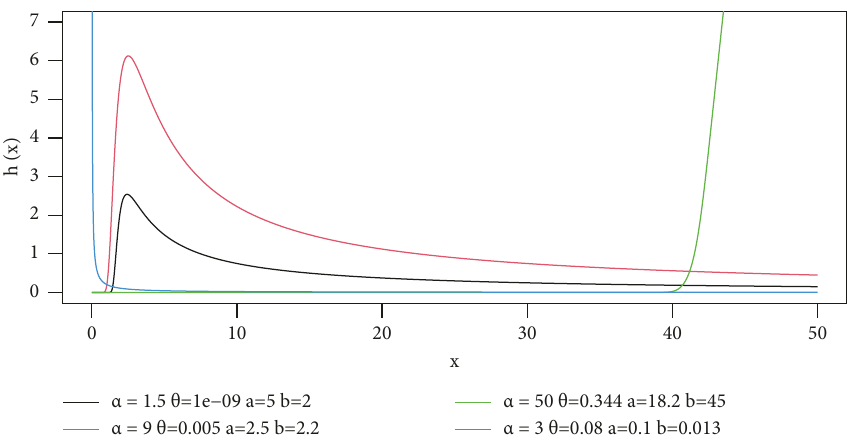
Figure 2: Failure rate function plots of the HMF